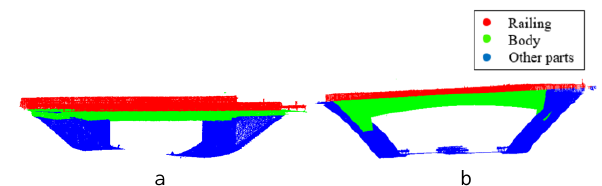
Figure 9. The results of point cloud segmentation: a: bridge 1; and b: bridge